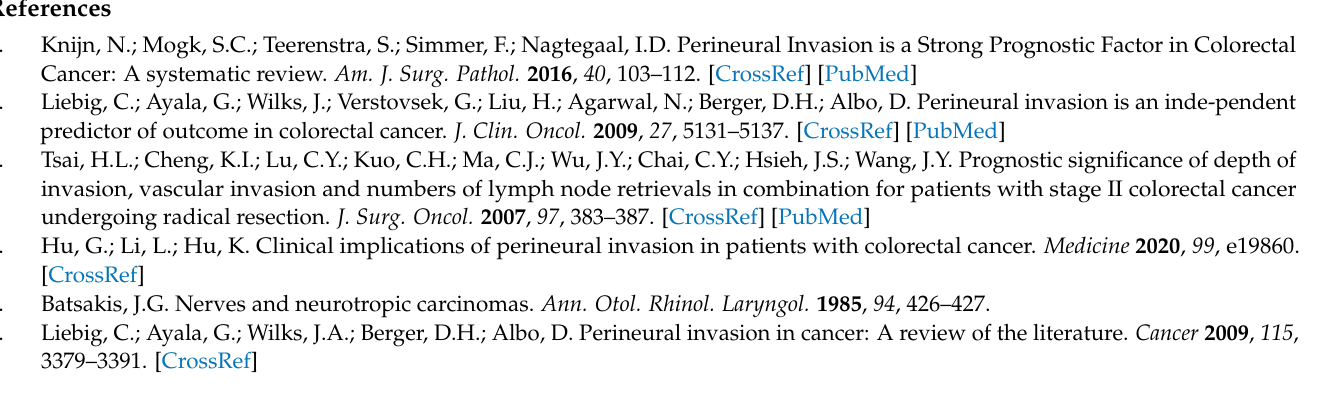
models; Figure S2: Representative FN and FP cases; Figure S3: Comparision of the number of parameters and inference time for SegFormer and U-Net; Table S1: Clinicopathological characteristics of colorectal cancer patients; Table S2: Performance for SegFormer trained on scratch and on pre- trained